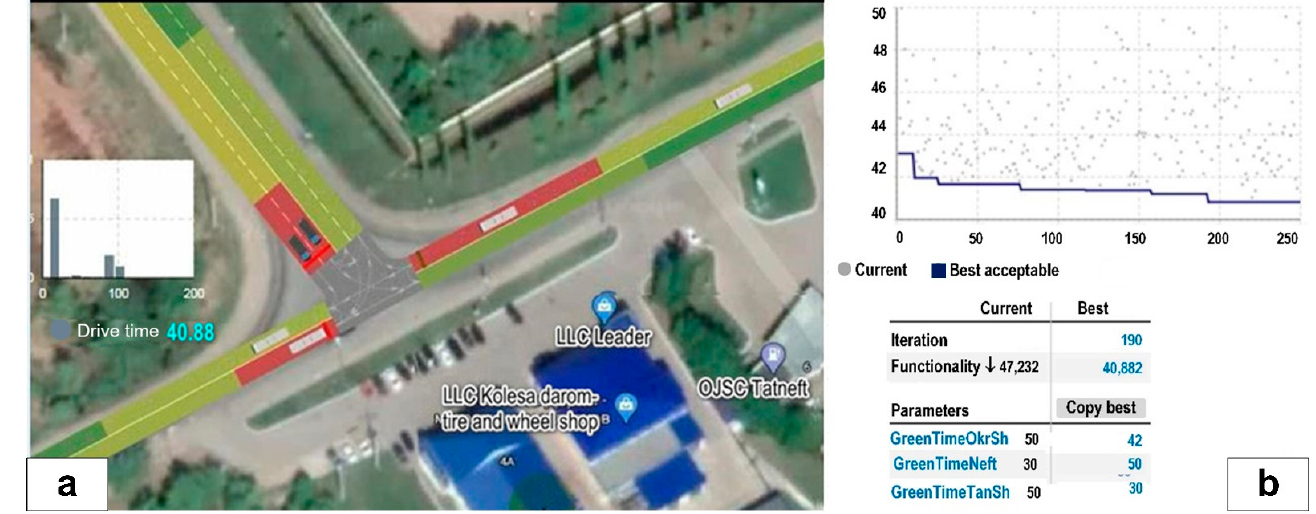
Figure 7. ( a ) SM of the road network section after the changes. ( b ) Optimization experiment results